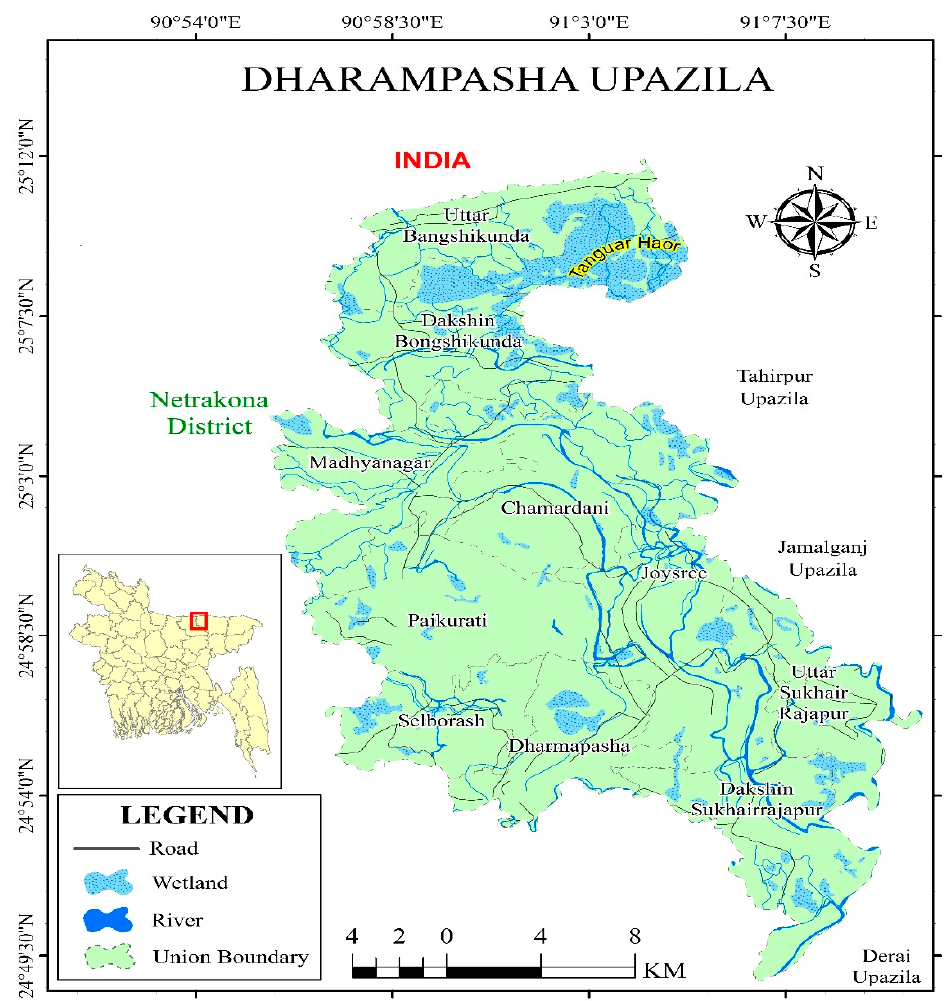
Figure 1. Map of Dharmapasha Upazila. Study areas are marked in the Upazila map.